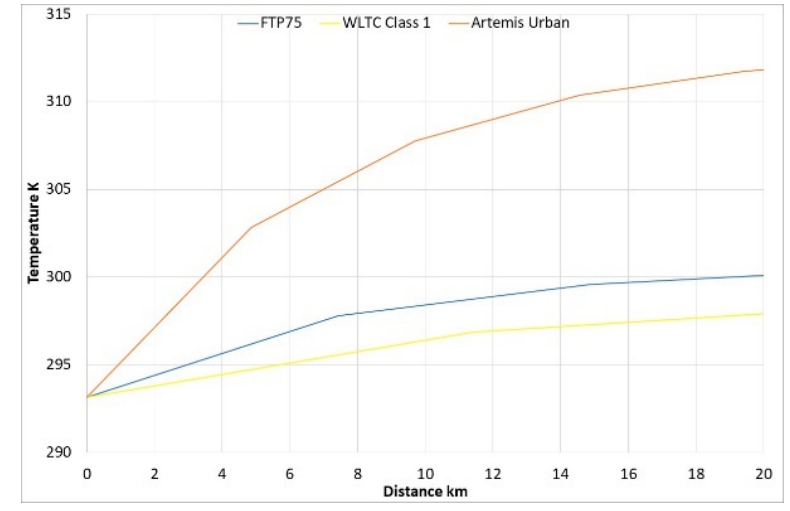
Figure 15. Temperature of the battery for the Artemis Urban, FTP75 and WLTC Class 1 with the standard battery.